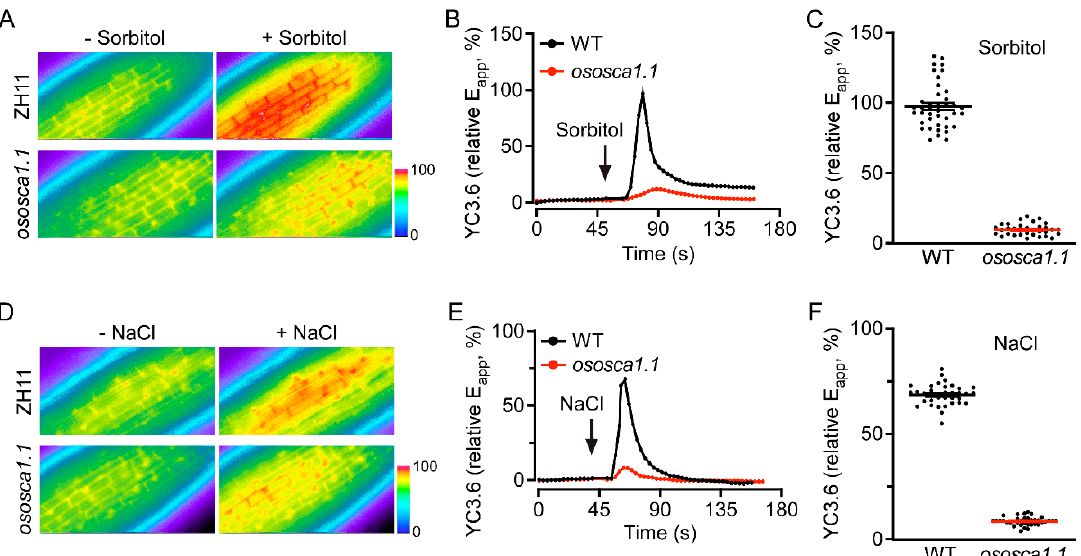
Figure 1. OsOSCA1.1 mediates hyperosmolality-induced [Ca 2+ ] cyt (OICI cyt ) and salt-induced [Ca 2+ ] cyt (SICI cyt ) increases in rice seedling roots. ( A – C ) OICI cyt was monitored in the root cells of ZH11 and ososca1.1, expressing Yellow Cameleon YC3.6 (YC3.6) under treatment with 250 mM of sorbitol. E app , relative apparent Förster resonance energy transfer (FRET) efficiency of YC3.6. ( A ) Typical image before and after treatment, ( B ) changes in [Ca 2+ ] cyt over time, and ( C ) mean change in [Ca 2+ ] cyt in response to 250 mM of sorbitol in ZH11 and ososca1.1 [means ± standard deviation (SD); n = 40]. In ( B ), black and red lines indicate [Ca 2+ ] cyt in ZH11 and ososca1.1 , respectively; black arrow indicates hyperosmolality stress initiation. In ( C ), black dots indicate individual experiments; black and red lines indicate mean changes. ( D – F ) SICI cyt was analyzed in the root cells of ZH11 and ososca1.1 expressing YC3.6 under treatment with 100 mM of NaCl. ( D ) Typical image before and after treatment, ( E ) changes in [Ca 2+ ] cyt over time, and ( F ) mean change in [Ca 2+ ] cyt in response to 100 mM NaCl in ZH11 and ososca1.1 (means ± SD; n = 40). In ( E ), black and red lines indicate [Ca 2+ ] cyt in ZH11 and ososca1.1 , respectively; black arrow indicates salt stress initiation. In ( F ), black dots indicate individual experiments; black and red lines indicate mean changes.